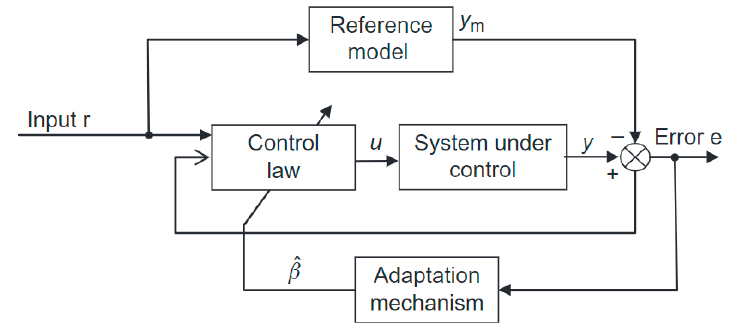
Figure 15. Adaptive block diagram representations [95].